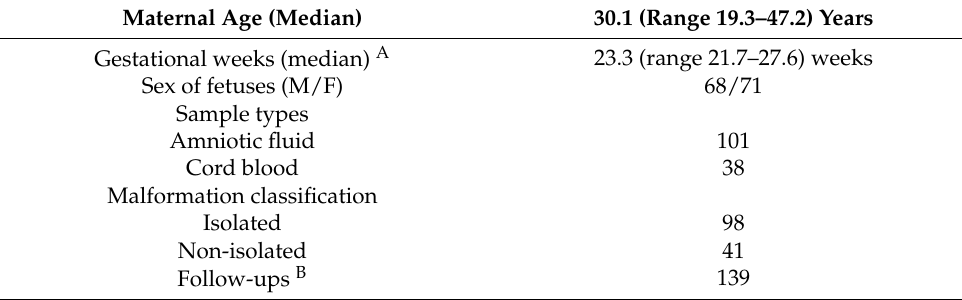
Table 1. Characteristics of the research population’s mothers and